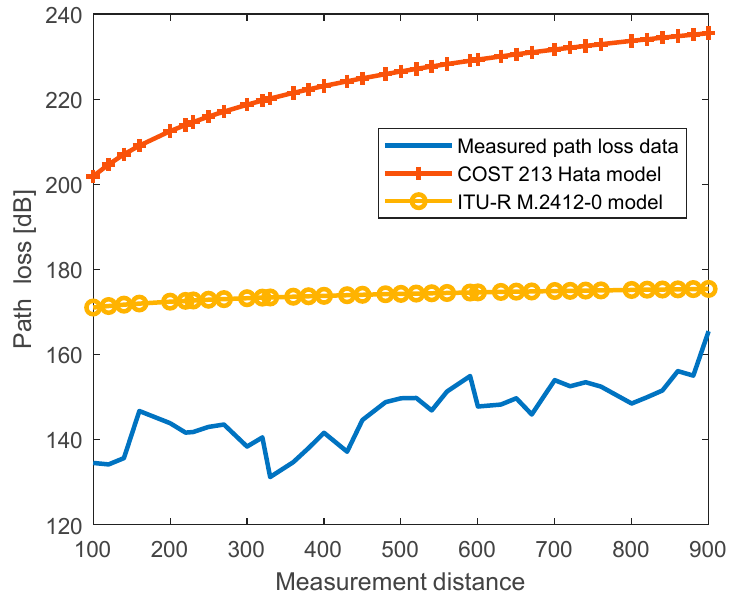
Figure 5. Measured Path loss values versus distance and Prediction comparison with standard COST 231 and ITU-R M.2412-0 model in site 1 Location 3.